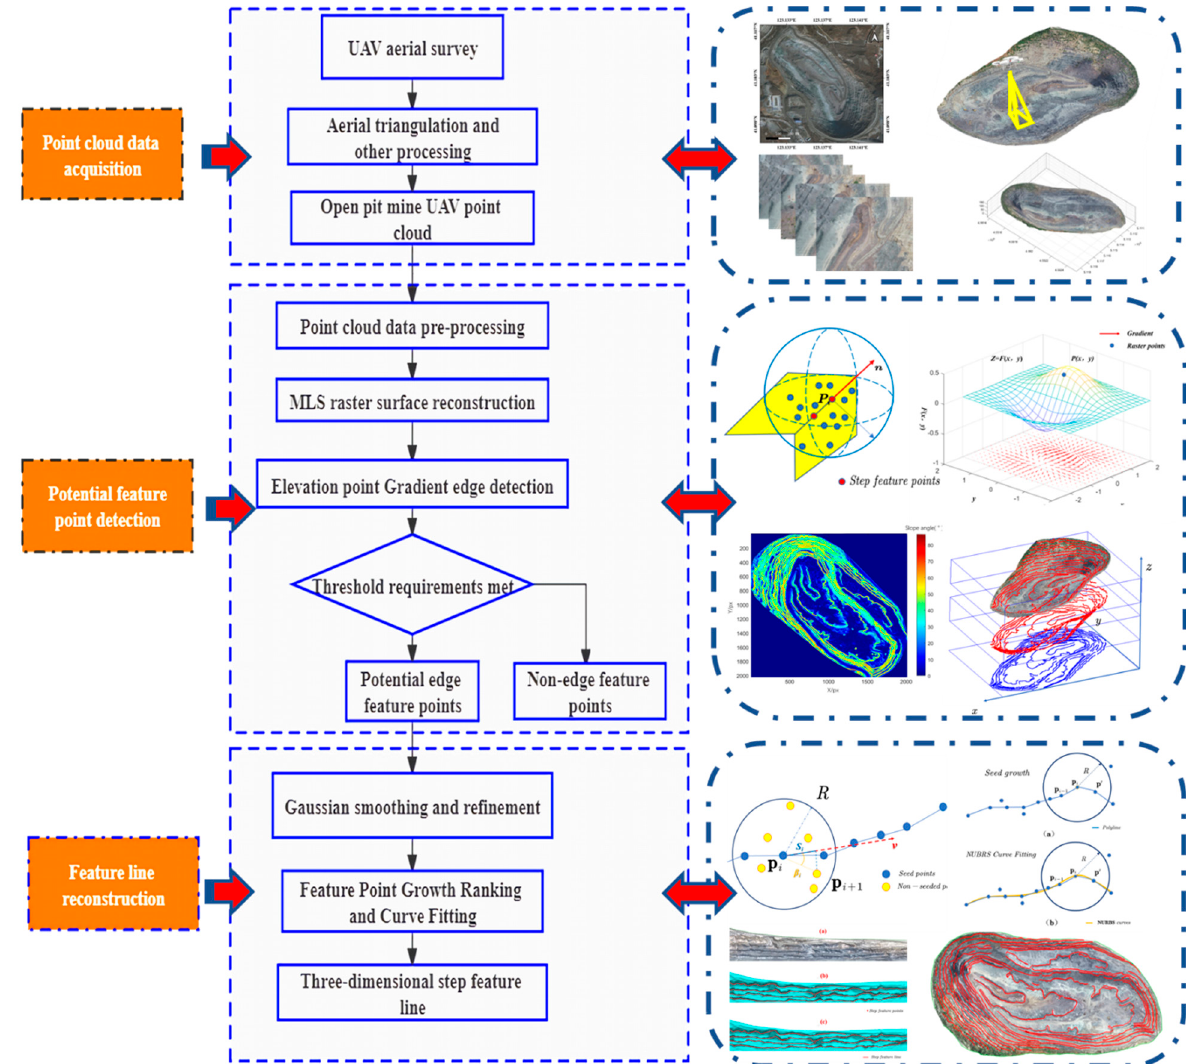
Figure 1. Schematic diagram of the step-feature-line extraction method.